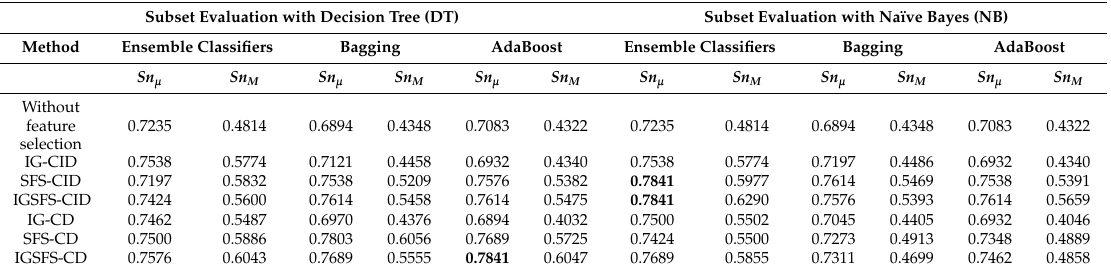
Table 5. Sensitivity comparison using micro-averaging and macro-averaging methods with ensemble learning methods for LC_dataset-1.